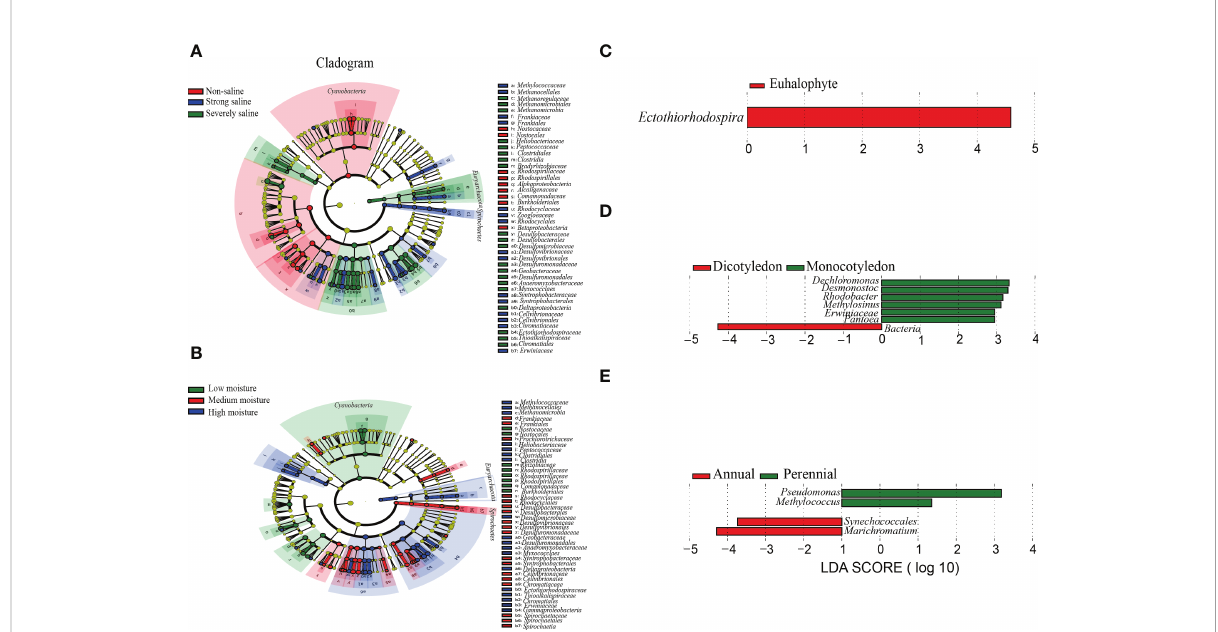
FIGURE 5 Phylogenetic dendrograms showing the biomarkers of diazotrophic microbes in the rhizospheric soil samples collected from Changyi (CY), Shouguang (SG), Dongying (DY) and Binzhou (BZ). (A) Different salinity levels. (B) Different soil moistures. (C) Different plant types based on salt resistance. (D) Different plant types based on cotyledon number. (E) Different plant types based on life span. The diazotrophic taxonomic levels from phylum to genus were exhibited with the circles from inside to outside. Diazotrophic abundance with no signi fi cant difference among individual soil samples was marked with yellow dots. The biomarkers were classi fi ed with different colors and shown on the right.